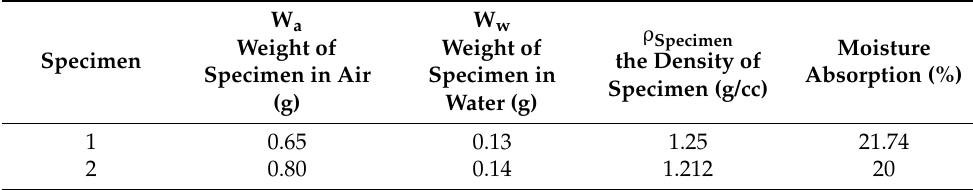
Table 1. Density test and moisture absorption properties.